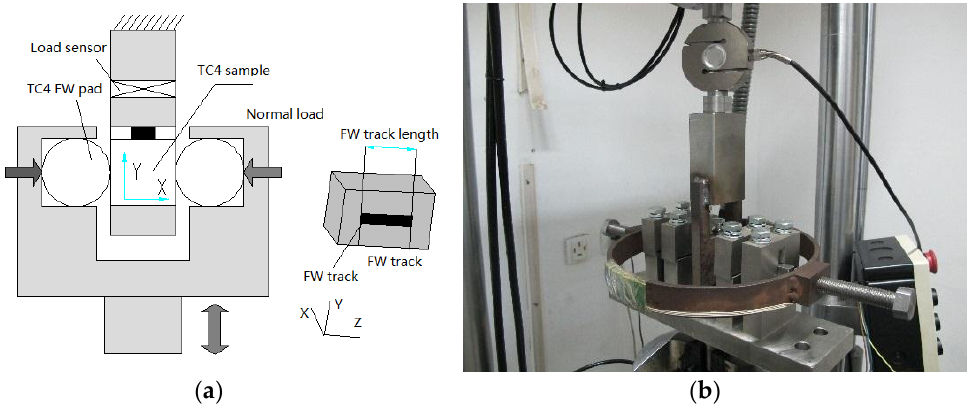
Figure 3. ( a ) Schematic diagram and ( b ) physical device of the fretting wear equipment.